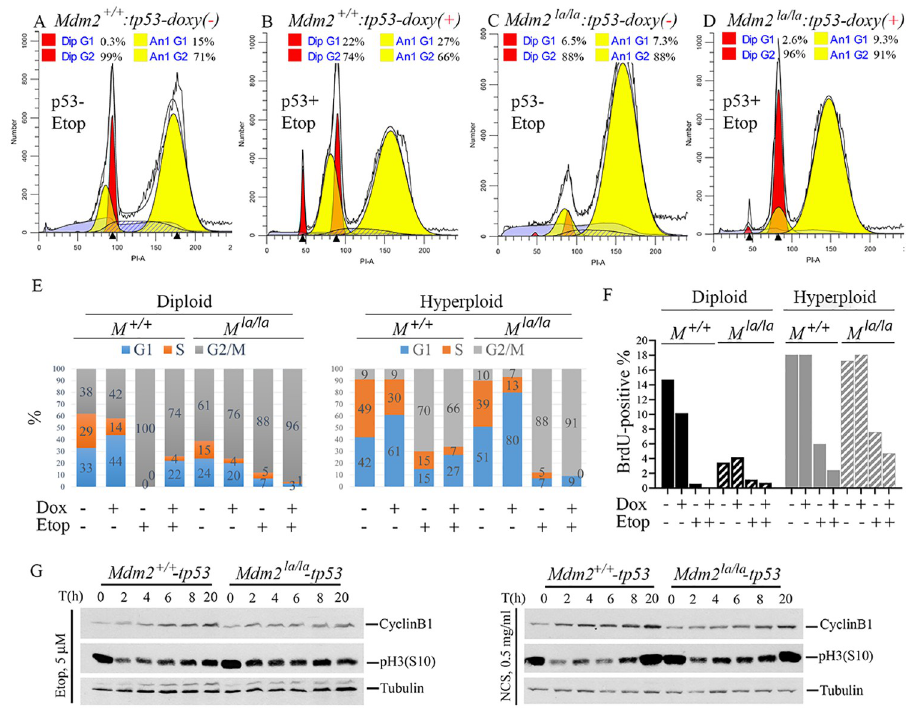
Fig 6. p53-dependent cell cycle regulation is abnormal in Mdm2 la/la MEFs after DNA damage. ( A , B ) Cell cycle profiles of Mdm2 +/+ -tetp53 after treatment with 5 μ M etoposide for 24h in the absence (A) or presence (B) of p53 induction with 200ng/ml doxycycline treatment for 24h followed by 5 μ M etoposide treatment for 24h. ( C, D ) Cell cycle profiles of Mdm2 la/la -tetp53 after treatment with 5 μ M etoposide for 24h in the absence (C) or presence (D) of p53 induction with 200ng/ml doxycycline treatment for 24h followed by 5 μ M etoposide treatment for 24h. ( E ) The experimental procedure was similar as in (A). Cell cycle distributions were shown before and after p53 induction (Dox +, 24h) and DNA damage (Etop+, 5 μ M 24h) in diploid and hyperploid cells determined by PI-staining and ModFit analysis of flow cytometry data. ( F ) Similar procedure as in (E) except for a 2h-BrdU-labeling step was added